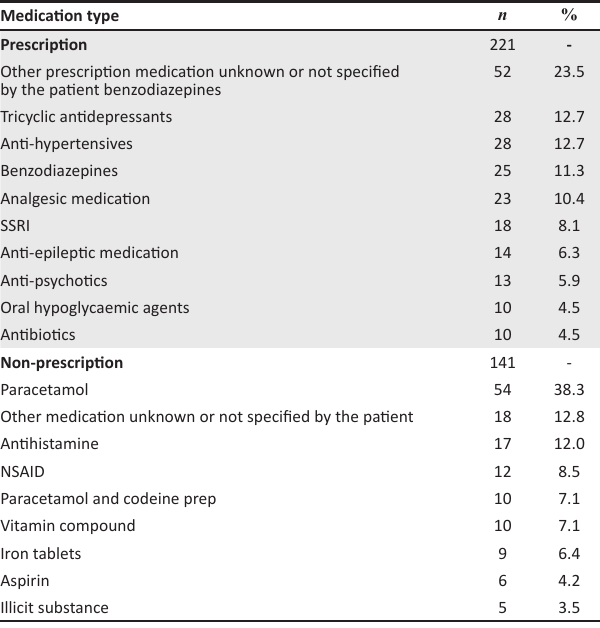
TABLE 3: Prescription and non-prescription medication taken by patients. Medication type n